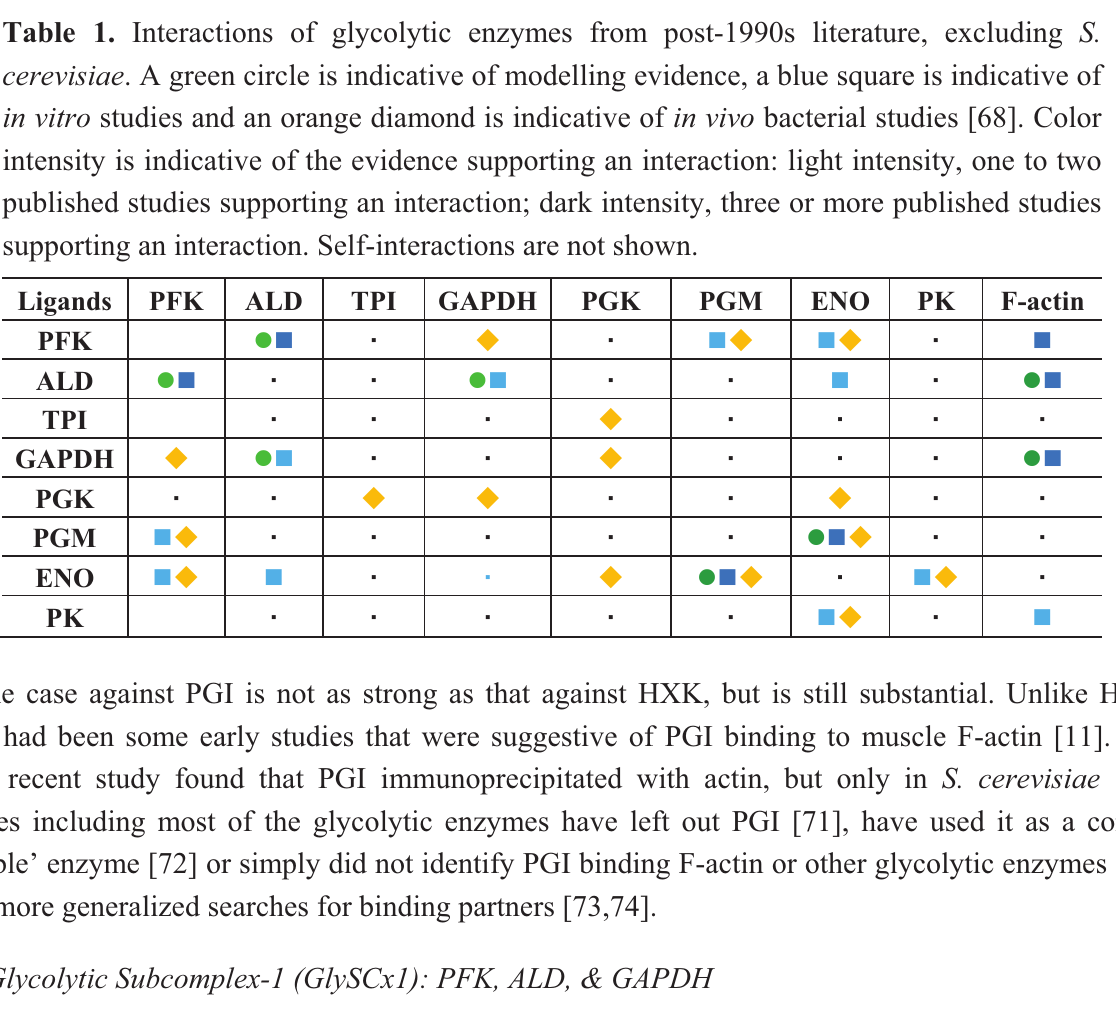
Table 1. Interactions of glycolytic enzymes from post-1990s literature, excluding